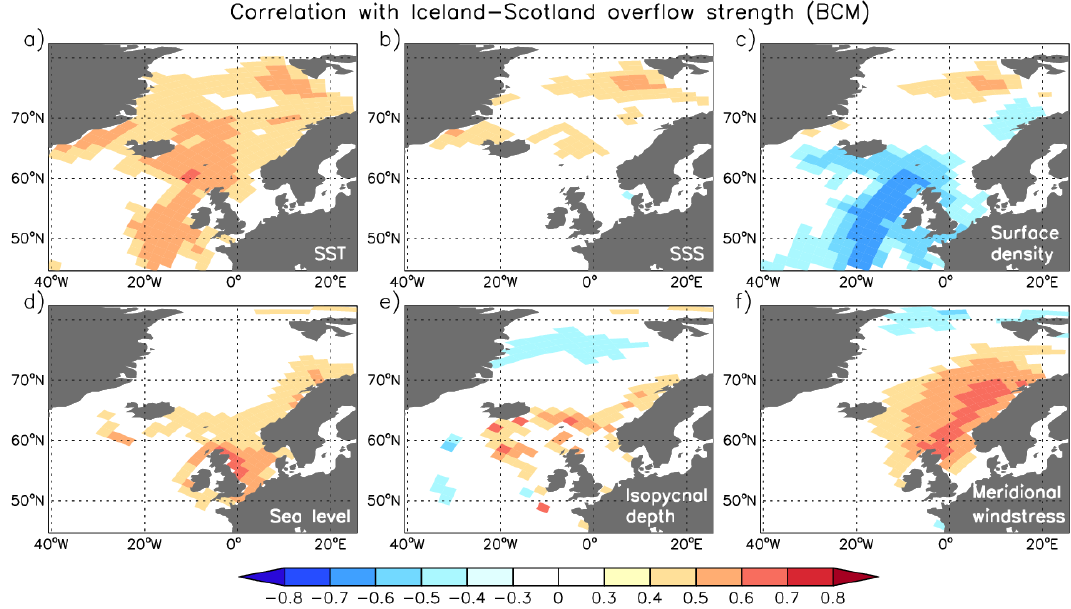
Figure 8. Zero-lag correlation coefficients between the Iceland–Scotland overflow strength and (a) the SST, (b) the SSS, (c) the surface density, (d) the sea surface height (linearly detrended prior to the analysis), (e) the depth of the isopycnal σ 2 = 36 . 946kgm − 3 and (f) the meridional wind stress component in BCM. The correlation analysis is based on annual values for the period AD1550 to 1999 with a 21- year running mean filter applied. Only correlation coefficients statistically significant at the 95% confidence level are shown (significance level: